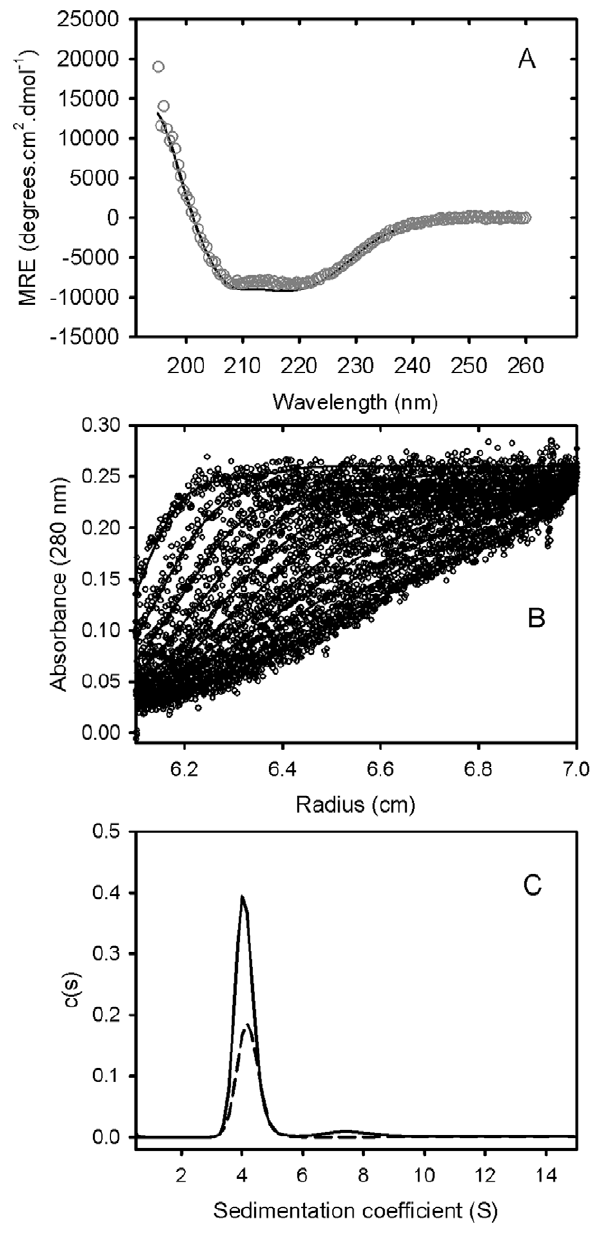
Figure 1. Solution characterisation of GRP78. (A) GRP78 was expressed and purified from E.coli cells, and subjected to circular dichroism spectroscopy. A representative spectrum for 0.15 mg/mL of purified GRP78 at 25 u C (open circles) and the fit from Dichroweb using filter set sp175 (solid line) is shown. (B) Sedimentation velocity analysis of GRP78 was performed by centrifuging 0.4 mg/mL of GRP78 at 28,000 rpm in an analytical ultracentrifuge. The resulting sedimenting absorbance boundaries were monitored at 280 nm and representative data shown as open circles. Fits to the experimental data using a c(S) sedimentation model are shown as solid lines. For clarity, only every 10th scan is shown. (C) Size distribution plots for 1.2 mg/mL of GRP78 (solid line) or 0.6 mg/mL of GRP78 (dashed line) calculated from fitting data represented in (B) to a c(S) sedimentation model.